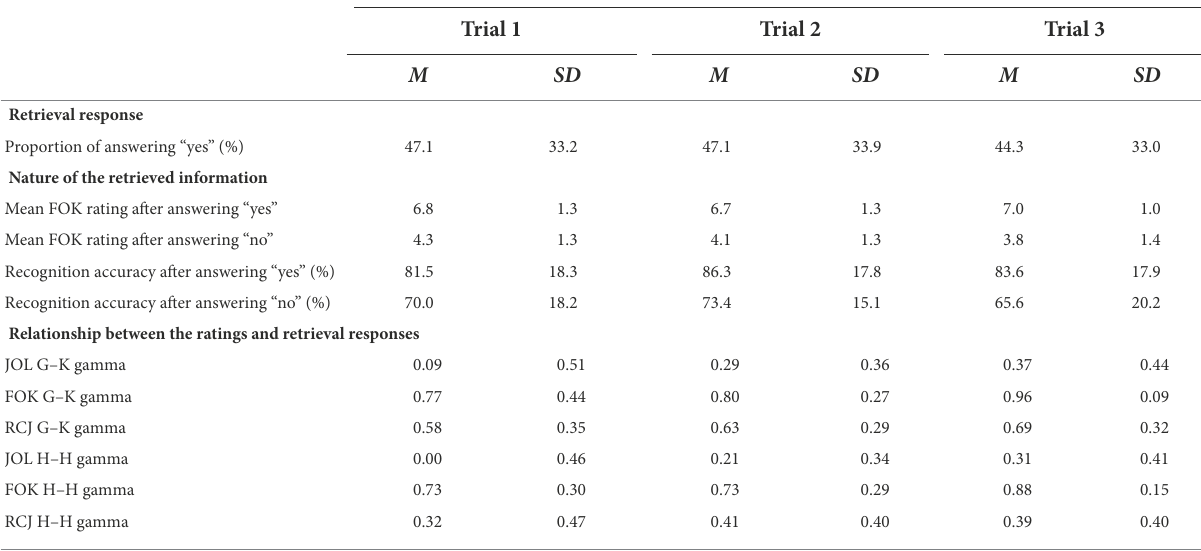
TABLE 3 Means and standard deviations of variables related to the retrieval response, nature of the retrieved information, and the relationship between the ratings and retrieval responses ( n = 24).